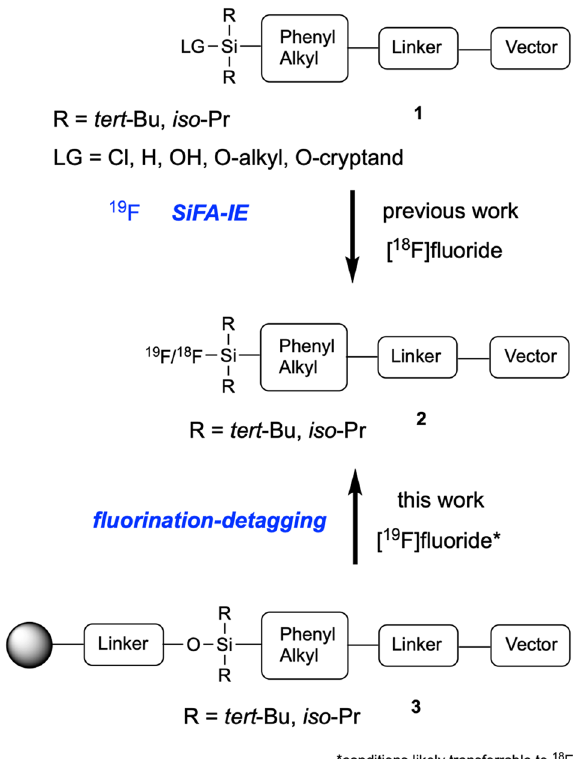
Fig. 1 Methods for the radiofluorination of silicon-based fluoride acceptors (SiFA). Leaving groups (LG) can be exchanged with (non)radioactive fluoride; a special case is the isotope exchange of non-radioactive fluoride with its radioactive counterpart (SiFA-IE); References for the replacement of different LGs with fluorine can be found in (Bernard-Gauthier et al.